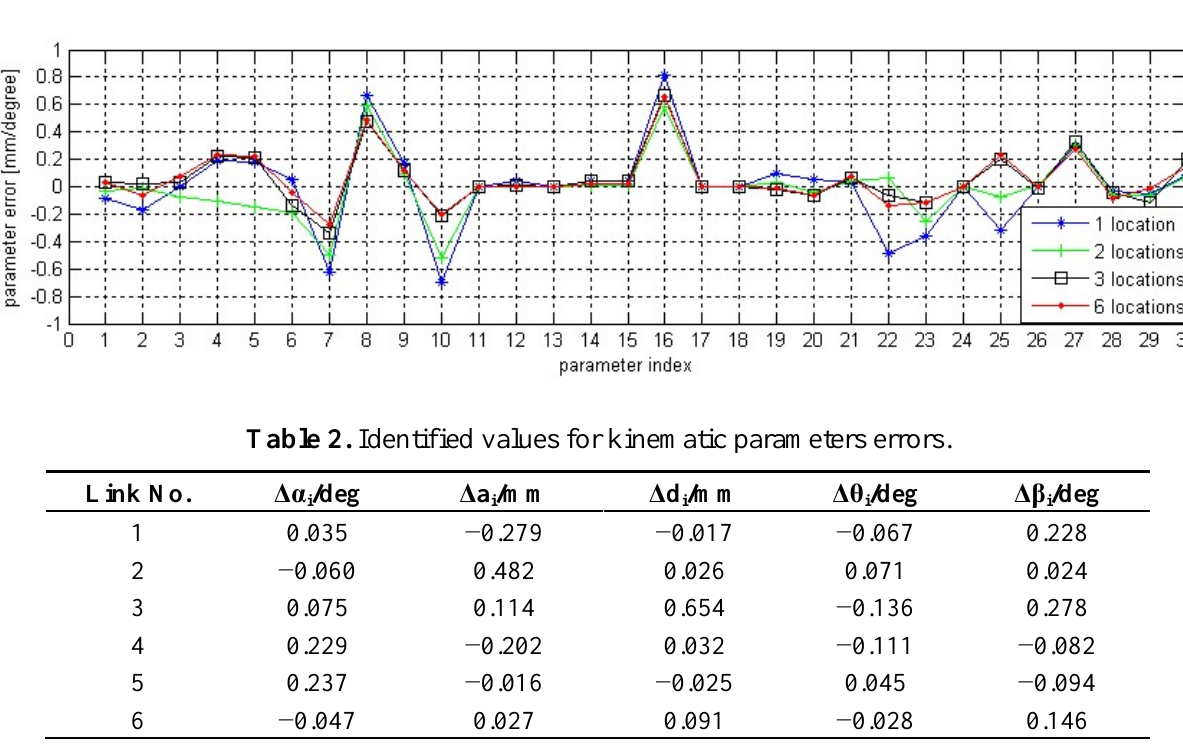
Figure 8. Comparison among the parameter sets from four different data sources.